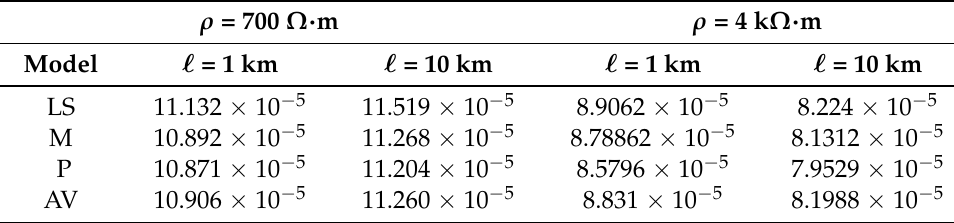
Table 6. χ ( % ) for the frequency-domain voltage V β in mode β for the considered FD soil models. ρ = 700 Ω ·